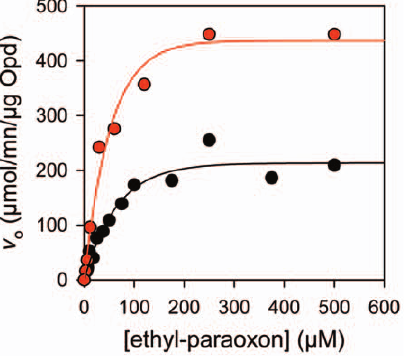
Figure 2. Catalytic properties of MamC-Opd in the magneto- somes sample. Michaelis-Menten curves for immobilized (black) and purified (red) Opd. For each enzymatic assays, we used 26 ng of immobilized Opd (20 m l of magnetosomes suspension) and 200 ng of soluble Opd. The mean deviation between the fitted Michaelis-Menten curves (lines) and the experimental data points (circles) is 4.2% for both curves.